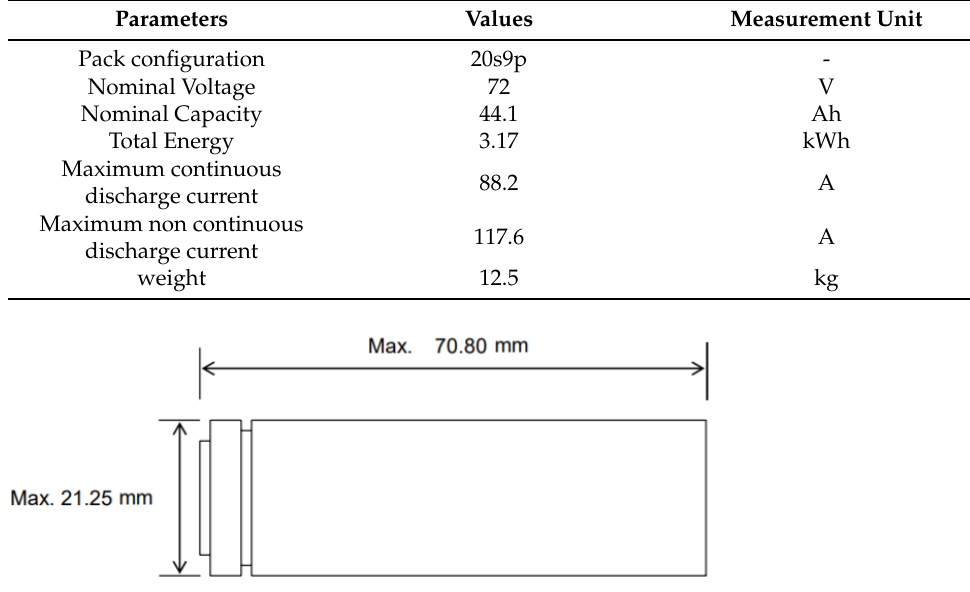
Table 2. Technical specification of the prototype battery pack.